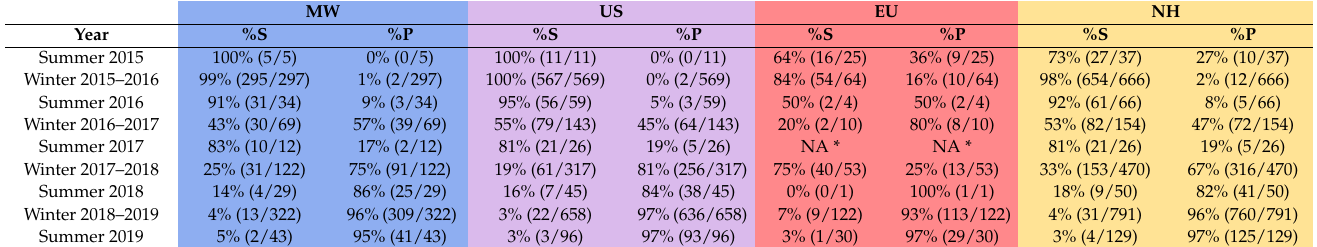
Table 5. Evolutionary timeline of hemagglutinin S200P variant by flu season and dataset, with the MW, US, EU, and NH datasets represented in blue, lavender, red, and yellow